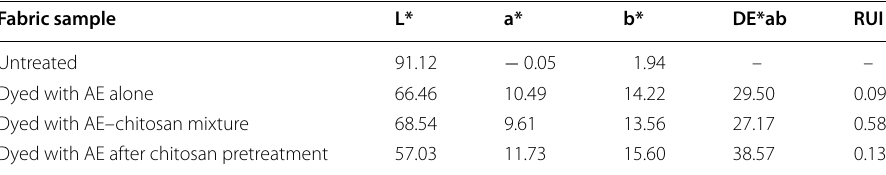
Table 2 Colorimetric data of cotton